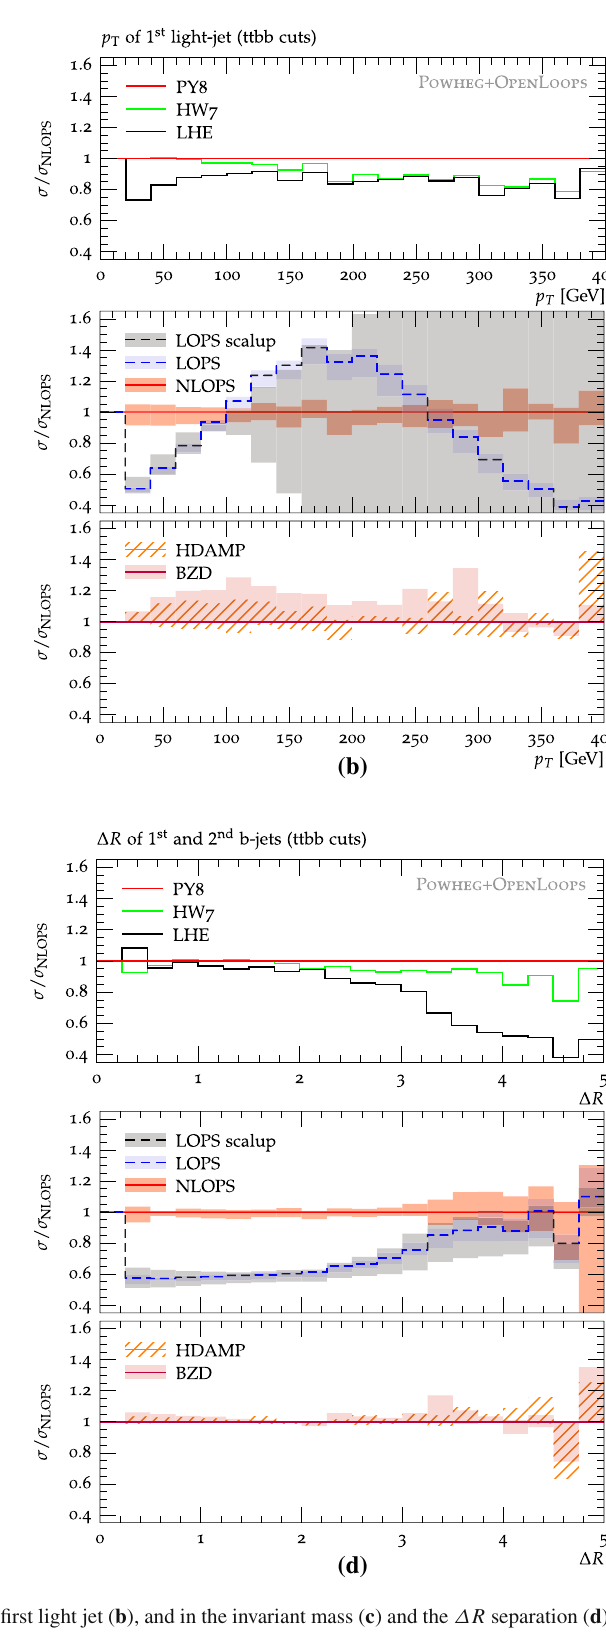
Fig. 10 Distributions in the p T of the second b -jet ( a ) in the p T of the first light jet ( b ), and in the invariant mass ( c ) and the Δ R separation ( d ) of the first two b -jets with ttbb cuts throughout. Predictions and uncertainties as in Fig.